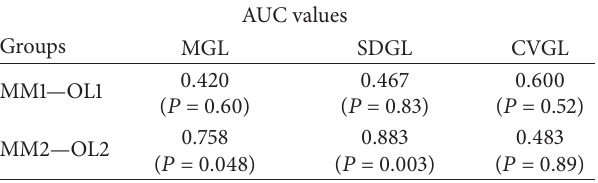
Table 2: AUC values of the ROC curve for the three parameters (mean (MGL), standard deviation (SDGL), and coefficient of vari- ation (CVGL) of gray level) considered and their corresponding significance. Null hypothesis tested (AUC = 0.5) corresponds to a null diagnostic value to differentiate between multiple myeloma and osteolytic metastases groups.